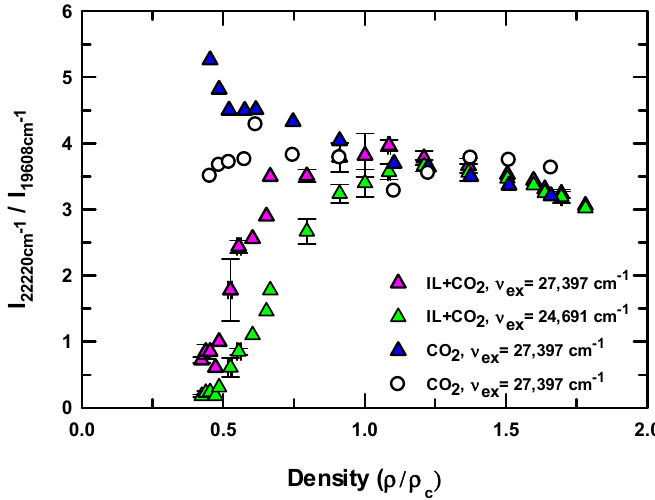
Figure 3. Computed emission intensity ratios for C153 in neat scCO 2 (circles and blue triangles) and [P 6,6,6,14 ] + [Tf 2 N] − / scCO 2 (pink and green triangles). Emission ratios (all triangles) are calculated from intensities at 22,222 cm − 1 / 19608 cm − 1 ( = I 450nm / I 510nm ), whereas open circles are for ratios calculated using the peak maximum value with an appropriate shift on the spectrum for the “510 nm” position. See text for details. Uncertainties are contained within the size of the symbol except for the visible error